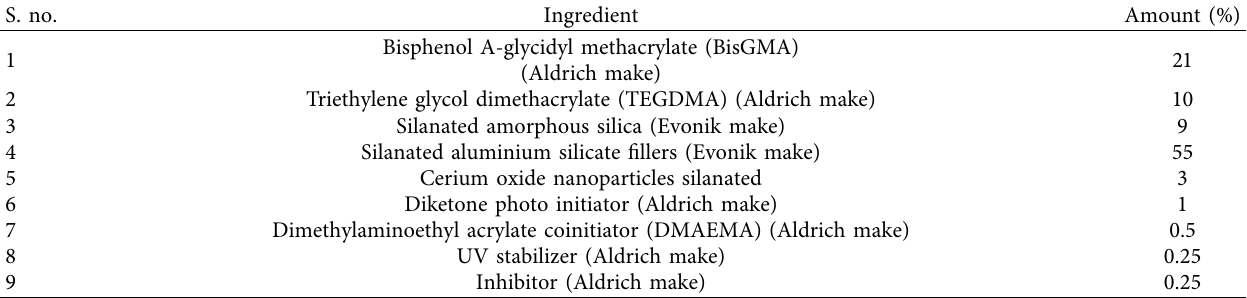
Table 1: Ingredients and their concentrations used for the manufacture of the experimental composite resin. S.